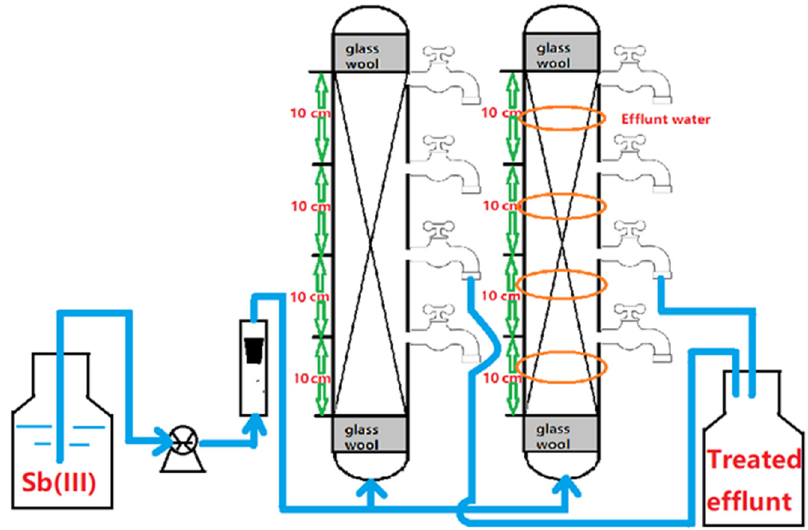
Figure 1. Schematic representation of the setup for the continuous flow system tests.